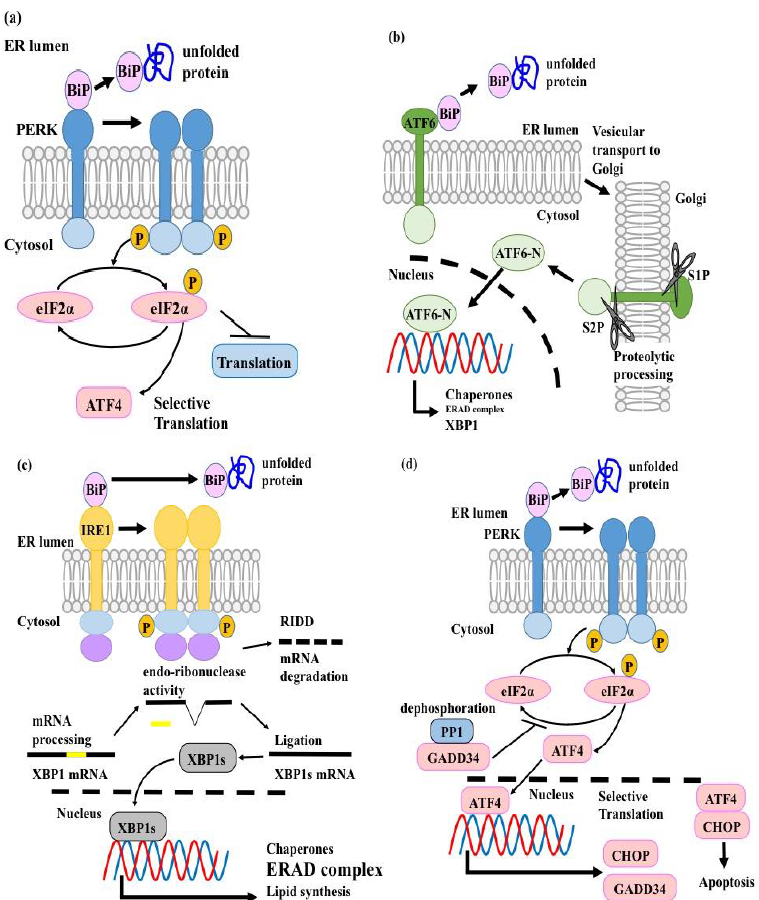
Figure 1. Signal transduction of the unfolded protein response (UPR). Under normal conditions, all three endoplasmic reticulum (ER) stress sensors (i.e., protein kinase double-stranded RNA-dependent (PKR)-like ER Kinase (PERK), activating transcription factor 6 (ATF6), and inositol-requiring enzyme 1 (IRE1)) are associated with binding immunoglobulin protein (BiP). When unfolded proteins accumulate in the ER, BiP dissociates from PERK, ATF6, and IRE1 to bind with the unfolded proteins. As a result, the three molecular sensors are activated: ( a ) PERK forms a homo-dimer complex and phosphorylates eIF2 α , which attenuates translation. This inhibits the incorporation of newly synthesized proteins into the ER. In parallel, the selective translation of the transcription factor ATF4 is carried out. ( b ) ATF6, which has dissociated from BiP, is transported into the Golgi apparatus and processed by the Golgi-resident endoproteases S1P and S2P. The resultant ATF6 cytosolic fragment acts as a transcription factor and activates the transcription of ER-resident molecular chaperones, which accelerate the folding of accumulated unfolded proteins. ( c ) Activated IRE1 homo-dimerizes and self-phosphorylates. This conformational change determines the nonconventional splicing of X-box binding protein 1 (XBP1) mRNA. The resultant XBP1 spliced isoform (XBP1s) acts as a transcription factor and induces the transcription of three groups of molecules. (i) ER-resident molecular chaperones. (ii) ERAD-related molecules, to remove unfolded proteins from ER. (iii) Lipid synthesis related molecules. IRE1 also shows regulated IRE1-dependent decay (RIDD) activity to decrease the translation of ER-resident proteins, after completing nonconventional splicing of the XBP1 mRNA. ( d ) If ER stress is too severe to be suppressed by the above-mentioned pathways, ATF4 acts as a transcription factor and induces the transcription of CCAAT / enhancer binding protein homologous transcription factor (CHOP) and GADD33. The ATF4 / CHOP heterodimer induces apoptosis to eliminate stressed cells. GADD33 negatively regulates the PERK pathway, by dephosphorylating eI2F α , to delay the activation of ATF4 / CHOP. The dashed line indicates the nuclear